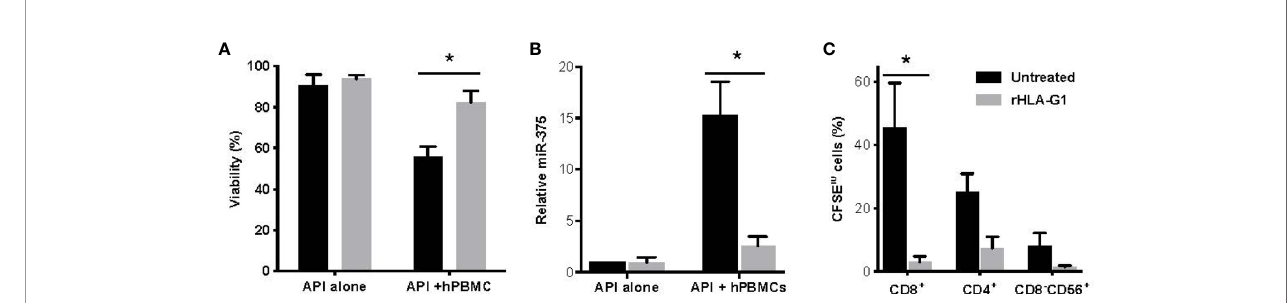
FIGURE 1 | Adult porcine islets (API) protection from hPBMCs in vitro with anti-SLA or recombinant HLA-G treatment comparing untreated to rHLA-G1. (A) Comparative analysis of AO/PI viability staining of API treated with anti-SLA-I antibody (PT-85) with and without hPBMCs. (B) Relative release of miR-375 in culture supernatants of API treated with anti-SLA-I antibody. (C) Proliferation of CD4 + and CD8 + T cells and CD56 + NK cells with anti-SLA-I treatment of API. Proliferation was assessed by fl ow cytometry analysis of decreasing CFSE fl uorescence. Co-cultures contained 100 IEQ/DNA of API (n = 2) and cultured with 10 5 human PBMCs for fi ve days. Data shown are presented as mean ±